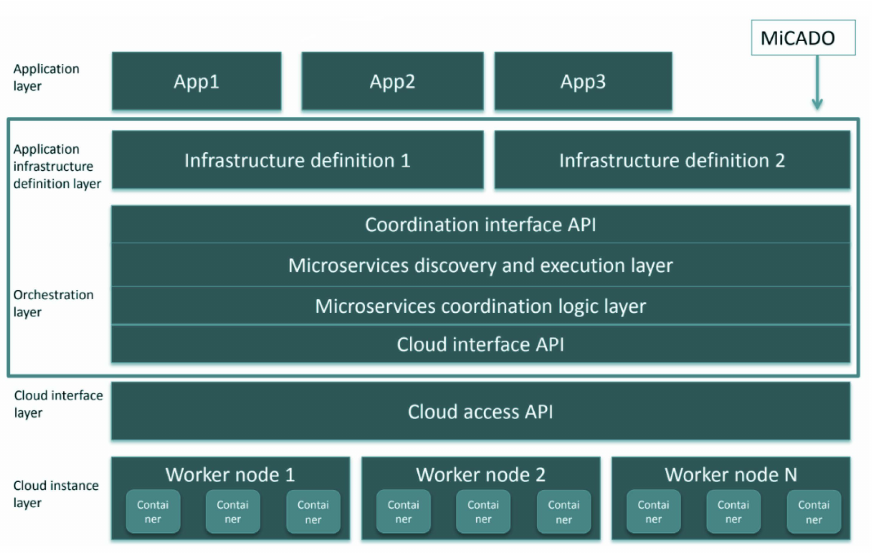
Figure 3. MiCADO Architecture; Adapted with permission from